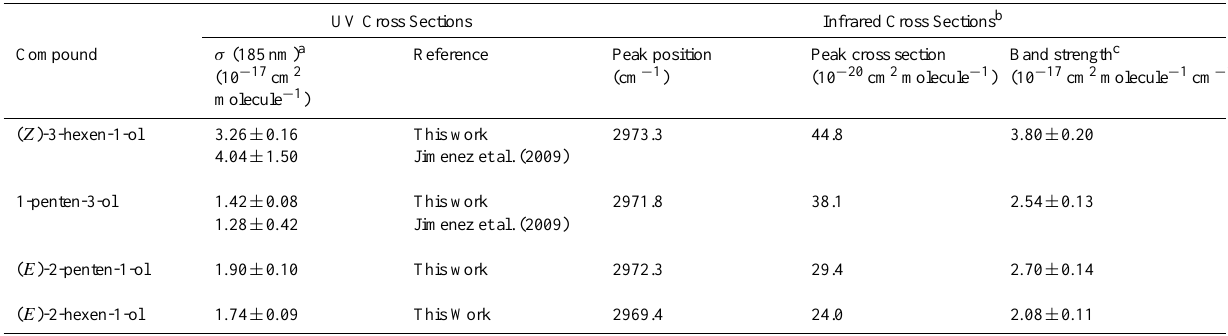
Table 1. Summary of UV and infrared absorption cross sections for ( Z )-3-hexen-1-ol, 1-penten-3-ol, ( E )-2-penten-1-ol, and ( E )-2-hexen- 1-ol measured in this work and taken from the